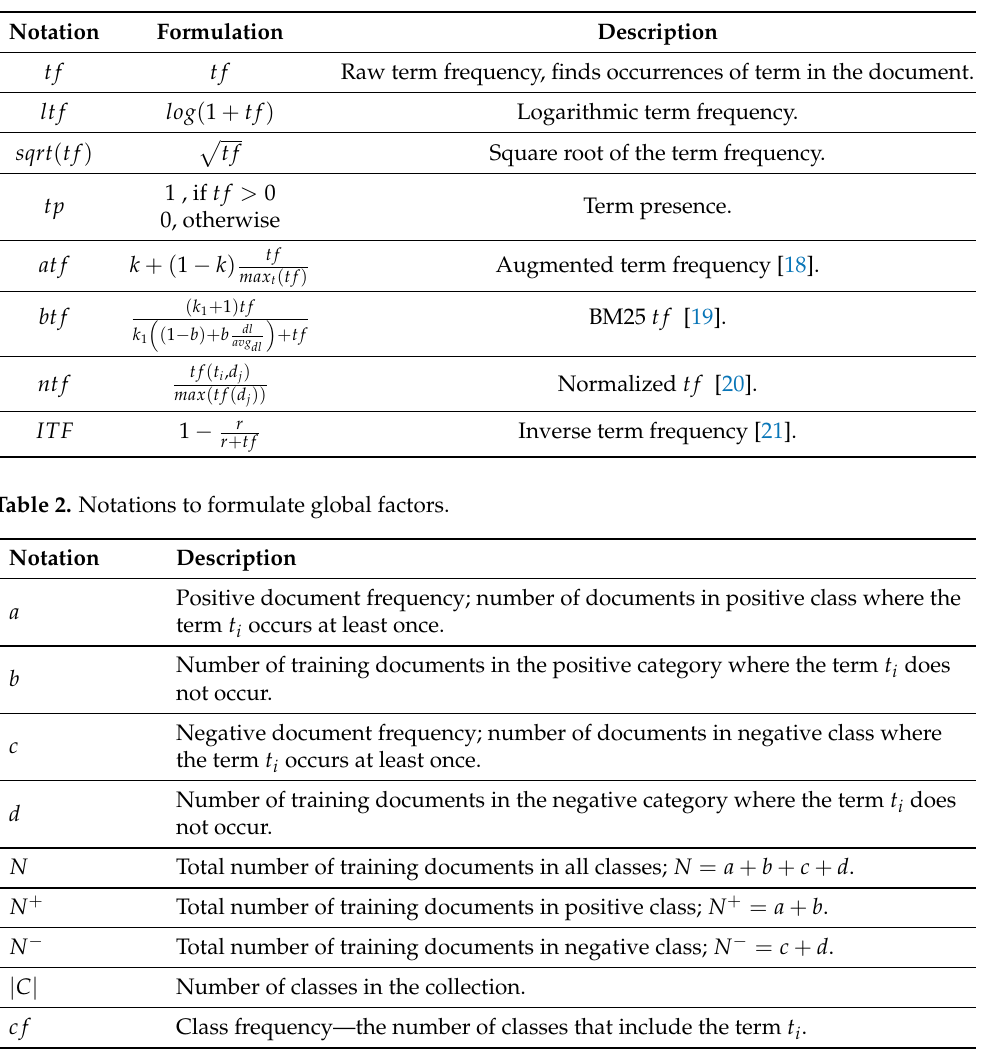
Table 1. Local weighting factors.